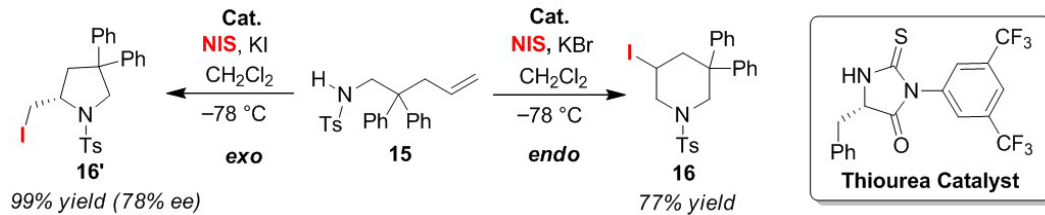
Figure8. Endo / exoselectiveiodo-amino-cyclizationreactionsofolefinicamines 15 usingathioureacatalyst.